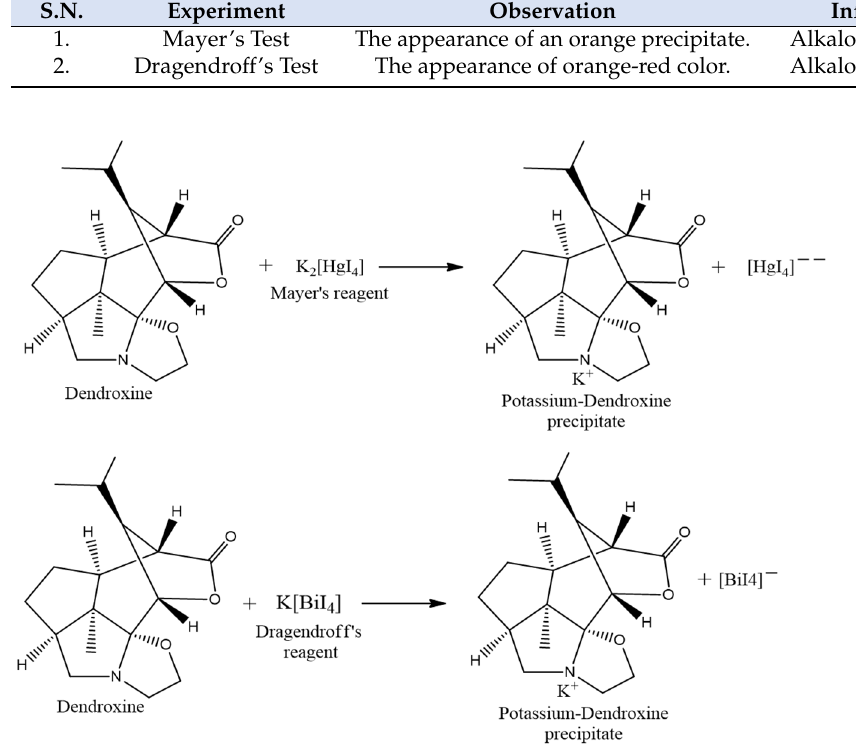
Table 1. Phytochemical screening of the extract solution. S.N. Experiment Observation Inference 1. Mayer’s Test The appearance of an orange precipitate. Alkaloid Presence 2. Dragendroff’s Test The appearance of orange-red color. Alkaloid Presence